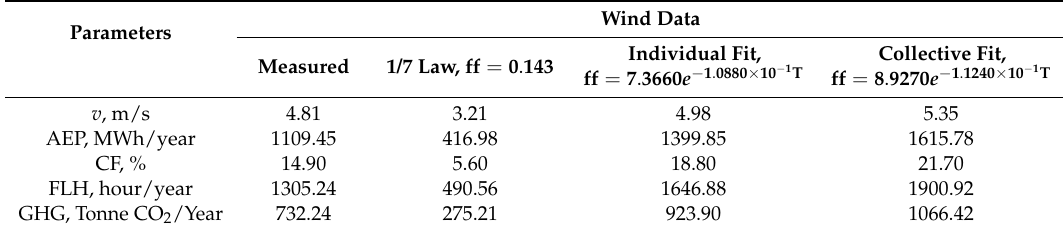
Table 10. Wind resource and energy yield parameters calculated at 55 m by the Kijal site using a single 850-kW rated power Gamesa G58-850 wind turbine.